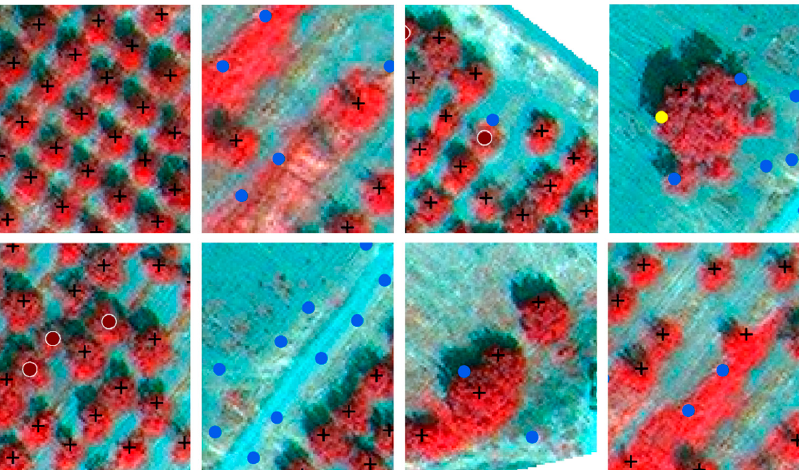
Figure 8. Examples of the tree detection performance of the TM-CS (the black cross, red circle, yellow circle, and blue circle symbols show the location of detected, undetected, overdetected, and falsely detected trees, respectively; a white color outline was added around the red circle symbol to enhance the contrast with the background).